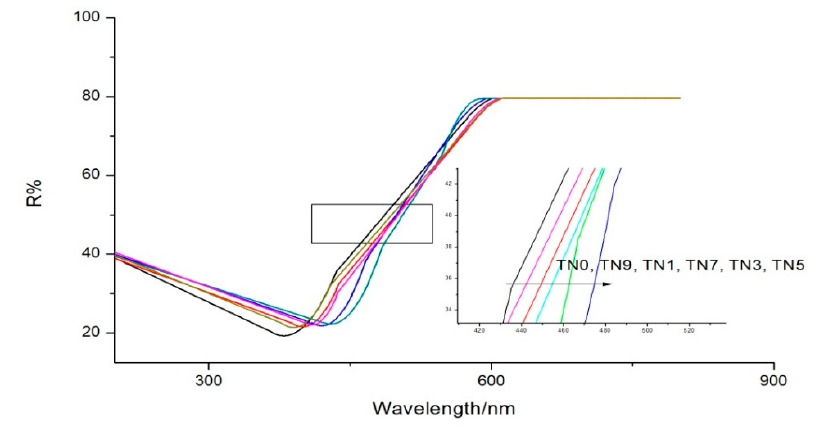
Figure 3. UV-vis DRS of TN0, TN1, TN3, TN5, TN7 and Figure 3. UV ‐ vis DRS of TN0, TN1, TN3, TN5, TN7 and TN9.